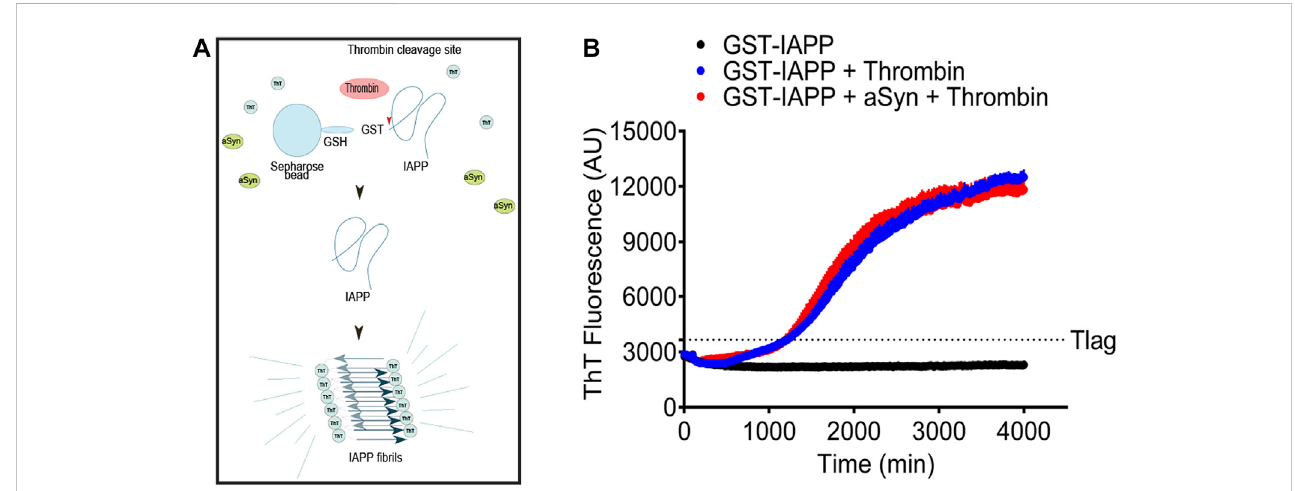
FIGURE 3 Monomeric aSyn does not affect IAPP fi brillation. (A) Schematic drawing of ThT assay on glutathione S-transferase tagged IAPP (GST-IAPP). GST-IAPP with thrombin cleavage site in linker region was expressed and bound to glutathione-Sepharose beads. Bead-GST-IAPP was then incubated with or without aSynfor60 minatroomtemperature.Theaddition ofthrombinresultedinthereleaseofmonomericIAPP,whichsequentiallymisfolded andformedamyloid fi brils. (B) When bead-GST-IAPP alone or bead-GST-IAPP preincubated with 5 µM aSyn was cleaved by thrombin, the formation of IAPP amyloid fi brils entered elongation phase at similar time points (1220 min and 1200 min) in both samples. Without the addition of thrombin, bead-GST-IAPP did not form detectable amyloid fi brils. The analysis was done in a black 96-well plate, and the ThT signal was measured at 480 nm emission with 440 nm excitation at 20 min intervals. Each data point represented mean ± SD ( n =